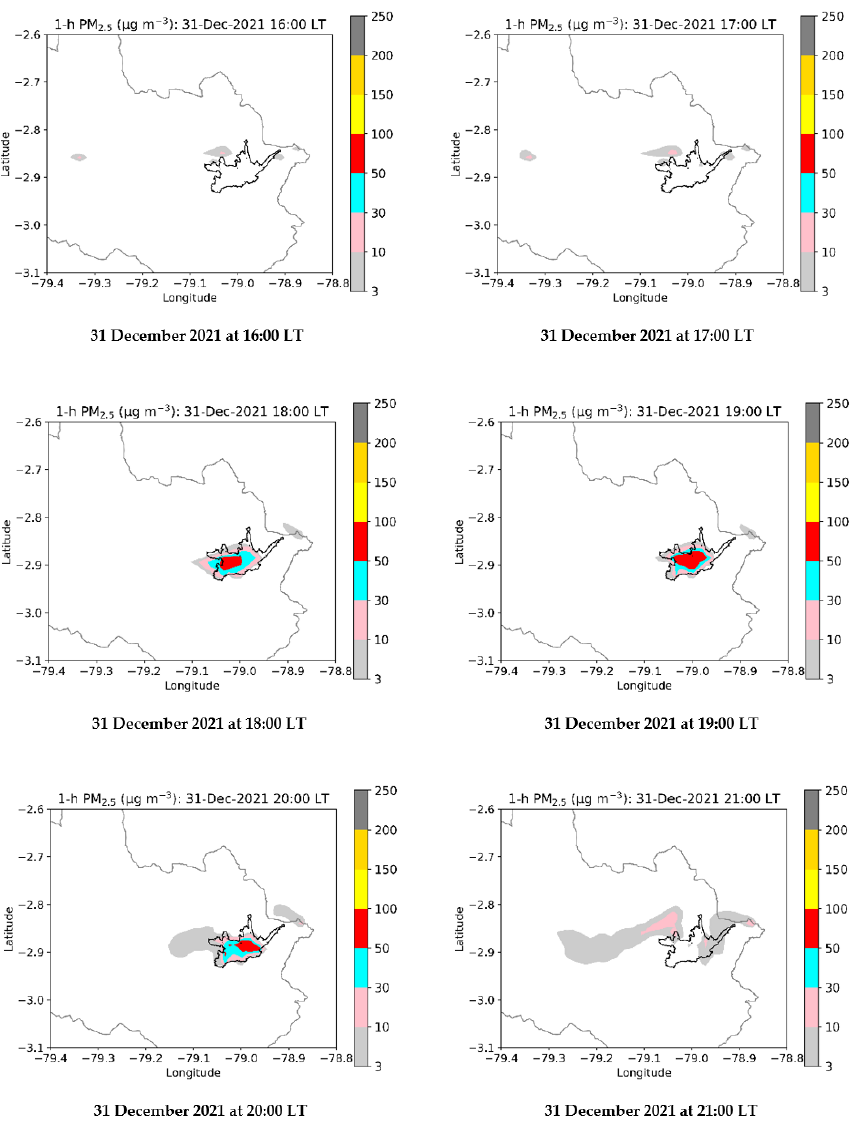
20221 at 21:00 LT. at 21:00 LT.